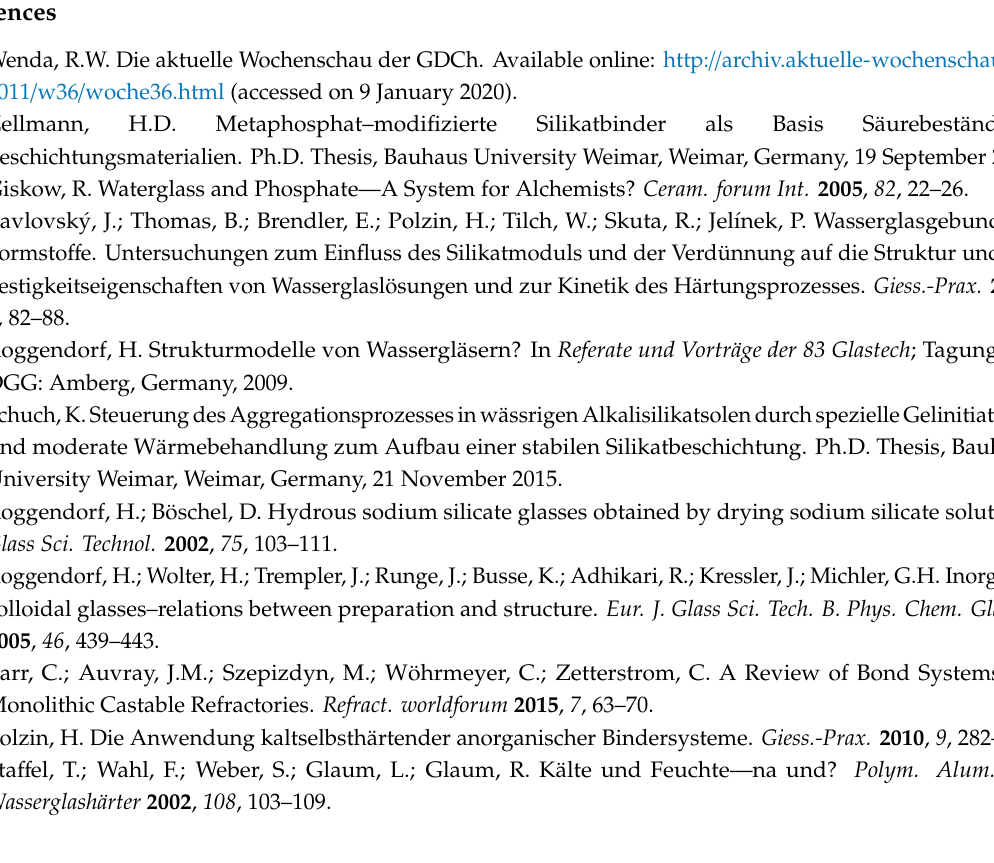
Figure S1: DMA measurements of the waterglass samples with di ff erent added content of AlPO 4 hardener at T A = 35 ◦ C. The reference is a waterglass sample without any hardener added. Figure S2: DMA measurements of the waterglass samples with di ff erent added content of AlPO 4 hardener at T A = 45 ◦ C. The reference is a waterglass sample without any hardener added. Figure S3: DMA measurements of the waterglass samples with di ff erent added content of BPO 4 hardener at T A = 35 ◦ C. The reference is a waterglass sample without any hardener added. Figure S4: DMA measurements of the waterglass samples with di ff erent added content of BPO 4 hardener at T A = 45 ◦ C. The reference is a waterglass sample without any hardener added. Gel point determination: Point of frequency-independence of the tan δ , T A = 25 ◦ C: frequency-independence of the tan δ in detail, curing time is corrected with regard to the time for preparation of the measurement ( = 5 min). Figure S5: 10 mass%, T A = 25 ◦ C. Figure S6: 20 mass%, T A = 25 ◦ C. Figure S7: 30 mass%, T A = 25 ◦ C. T A = 35 ◦ C and T A = 45 ◦ C: Overview of frequency-independence of the tan δ directly from the software (that means without time correction). Figure S8: AlPO4, T A = 35 ◦ C. Figure S9: AlPO4, T A = 45 ◦ C. Glass point determination: Maximum of the Loss modulus E” (1 Hz). T A = 25 ◦ C: Glass point determination in detail, curing time is corrected with regard to the time for preparation of the measurement ( = 5 min). Figure S10: 10 mass%, T A = 25 ◦ C. Figure S11: 20 mass%, T A = 25 ◦ C. Figure S12: 30 mass%, T A = 25 ◦ C. T A = 35 ◦ C and T A = 45 ◦ C: Overview of the glass point determination directly from the software (that means without time correction). Figure S13: AlPO4, T A = 35 ◦ C. Figure S14: AlPO4, T A = 45 ◦ C. BPO4 hardener a) Gel point determination: Point of frequency-independence of the tan δ , Overview directly from the software (that means without time correction). Figure S15: BPO4, T A = 25 ◦ C. Figure S16: BPO4, T A = 35 ◦ C. Figure S17: BPO4, T A = 45 ◦ C. b) Glass point determination: Maximum of the Loss modulus E” (1 Hz). Figure S18: BPO4, T A = 25 ◦ C. Figure S19: BPO4, T A = 35 ◦ C. Figure S20: BPO4, T A = 45 ◦